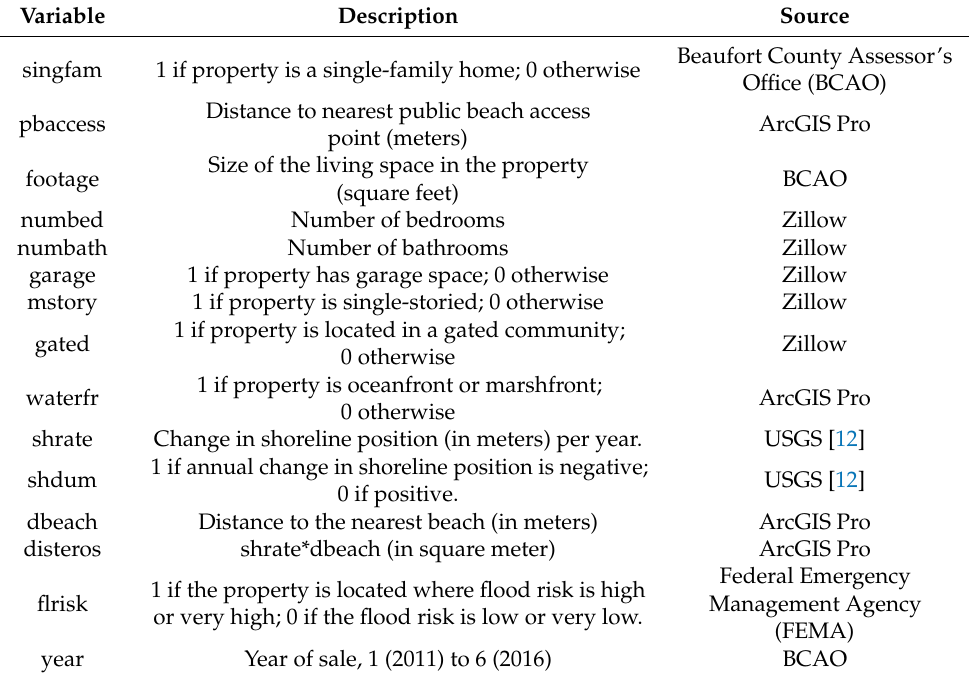
Table 1. Variable descriptions and data